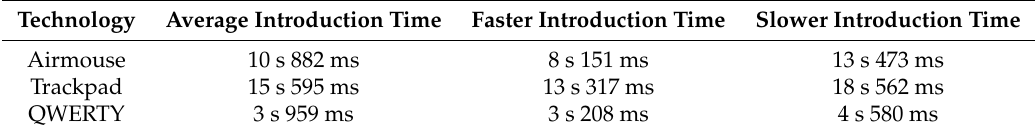
Table 9. Task 5-time needed for typing the word “ronaldo” using three different haptic technologies.